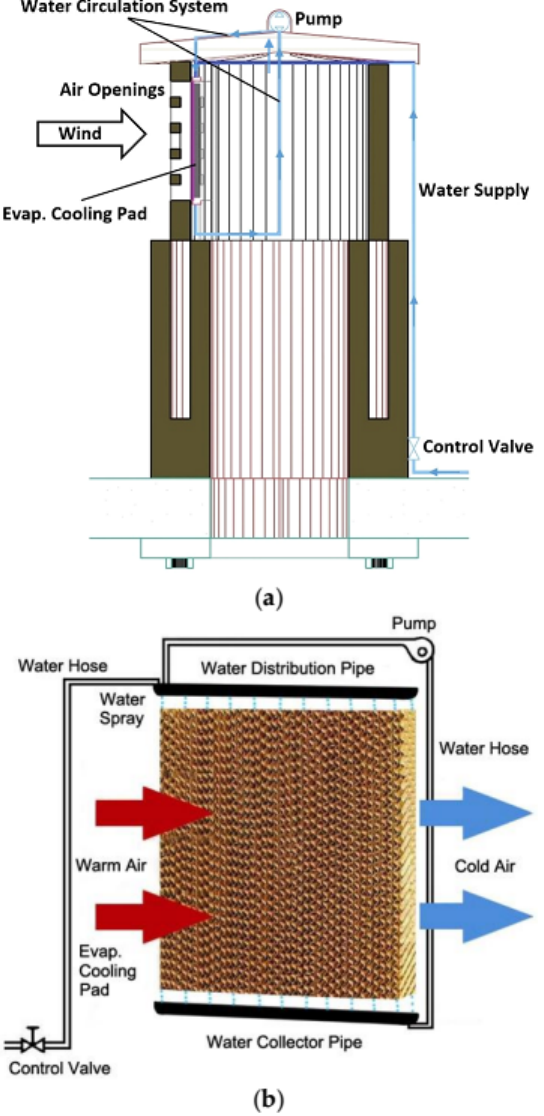
Figure 6. A schematic illustration of ( a ) installation position of moistened pad in the wind tower and ( b ) water distribution system as well as air cooling by the moist